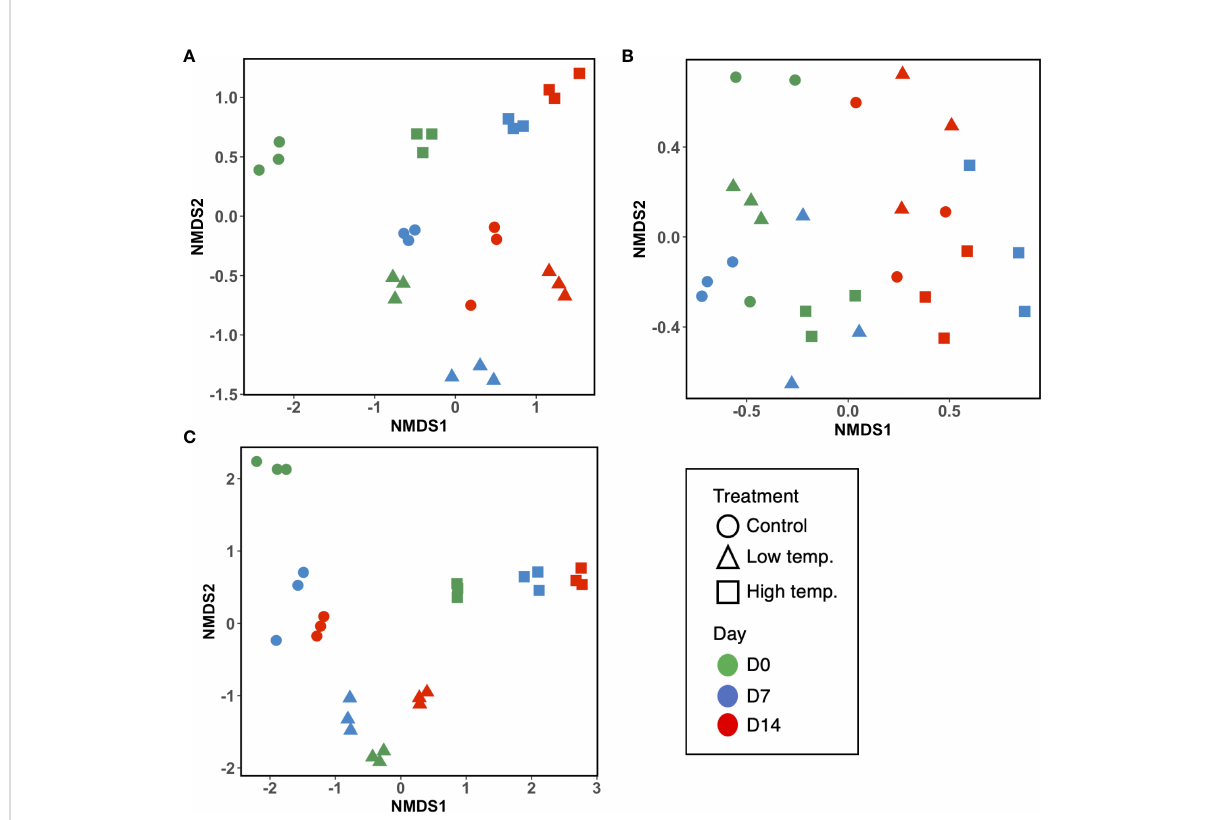
FIGURE 5 Nonmetric multidimensional scaling (NMDS) ordination plots based on Bray – Curtis distance indicating bacterial community dissimilarity among (A) fecal, (B) skin mucus, and (C) water samples. Ordination plots show the clustering of bacterial communities according to the temperature treatments and time points. Each sample plot is color-coded according to the time point (green, Day 0; blue, Day 7; and red, Day 14), and the shapes represent the temperature treatments (circle= control, triangle= low, and square= high